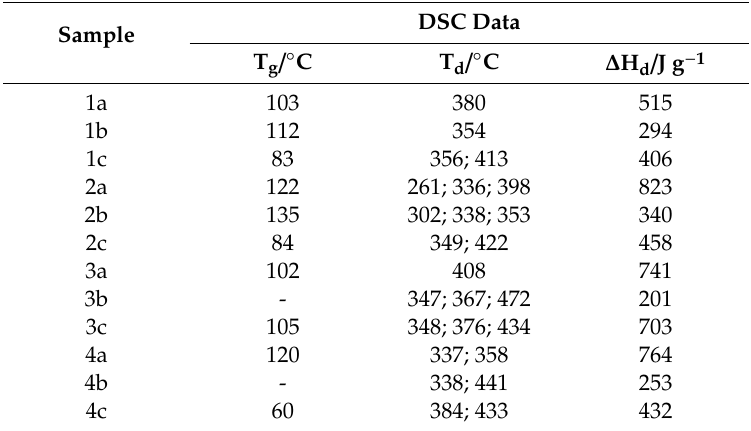
Figure 18. Differential scanning calorimetry (DSC) curves of starting (1a, 2a, 3a, 4a) and new (1c, 2c, 3c, 4c) materials obtained after thiol-ene reactions with HEMA. Table 8. Results of DSC analysis.